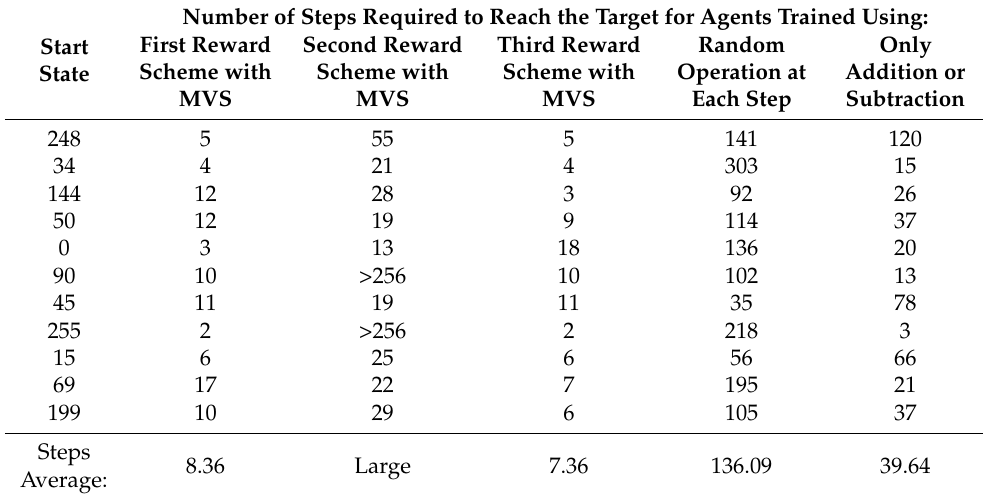
Table 4. Comparison between agents trained using different reward schemes. Number of Steps Required to Reach the Target for Agents Trained Using: Start State